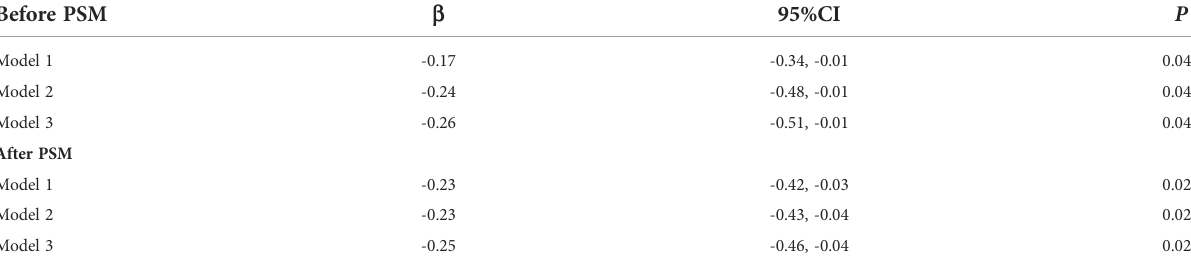
TABLE 4 Association between GLP-1RAs use and FIB-4 before and after PSM. Before